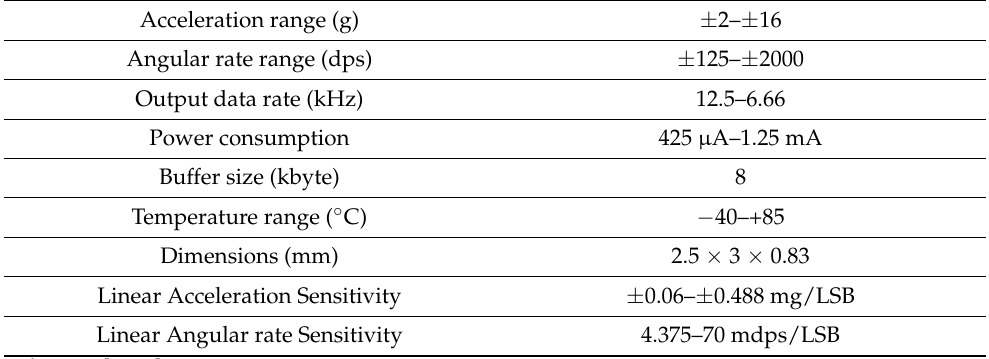
Figure 1. This figure shows the SARput drop-test apparatus ( left ) and the drop location ( right ). The vest is secured using anchor points. Table 1. Specifications for